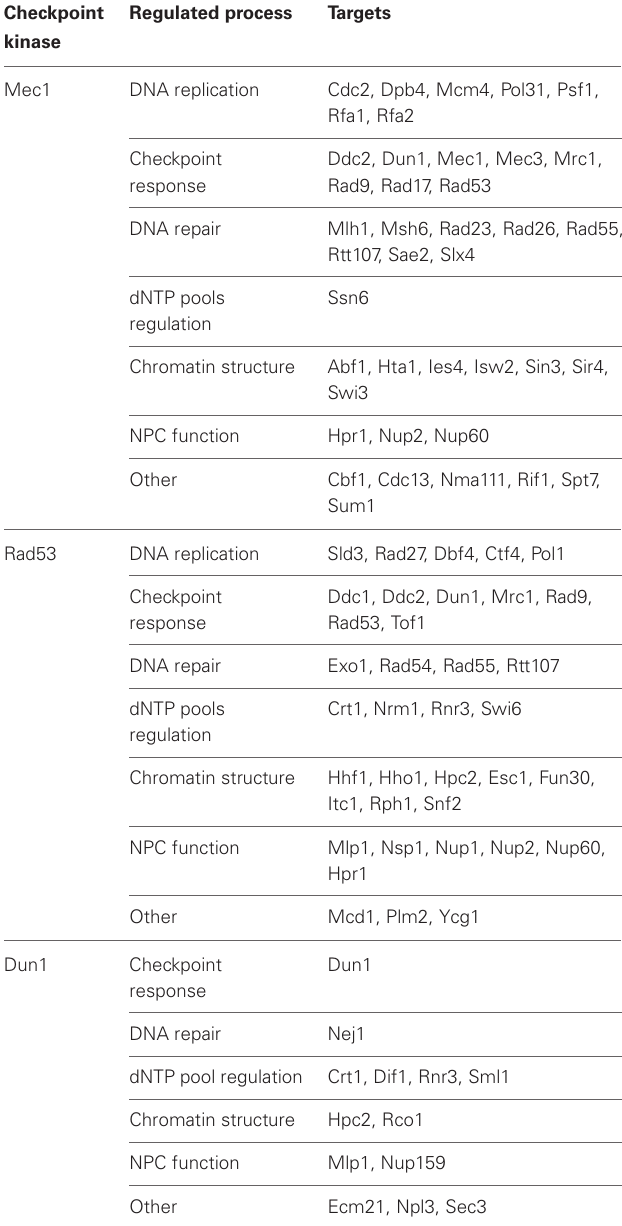
Table 2 | Checkpoint kinases phosphorylation targets